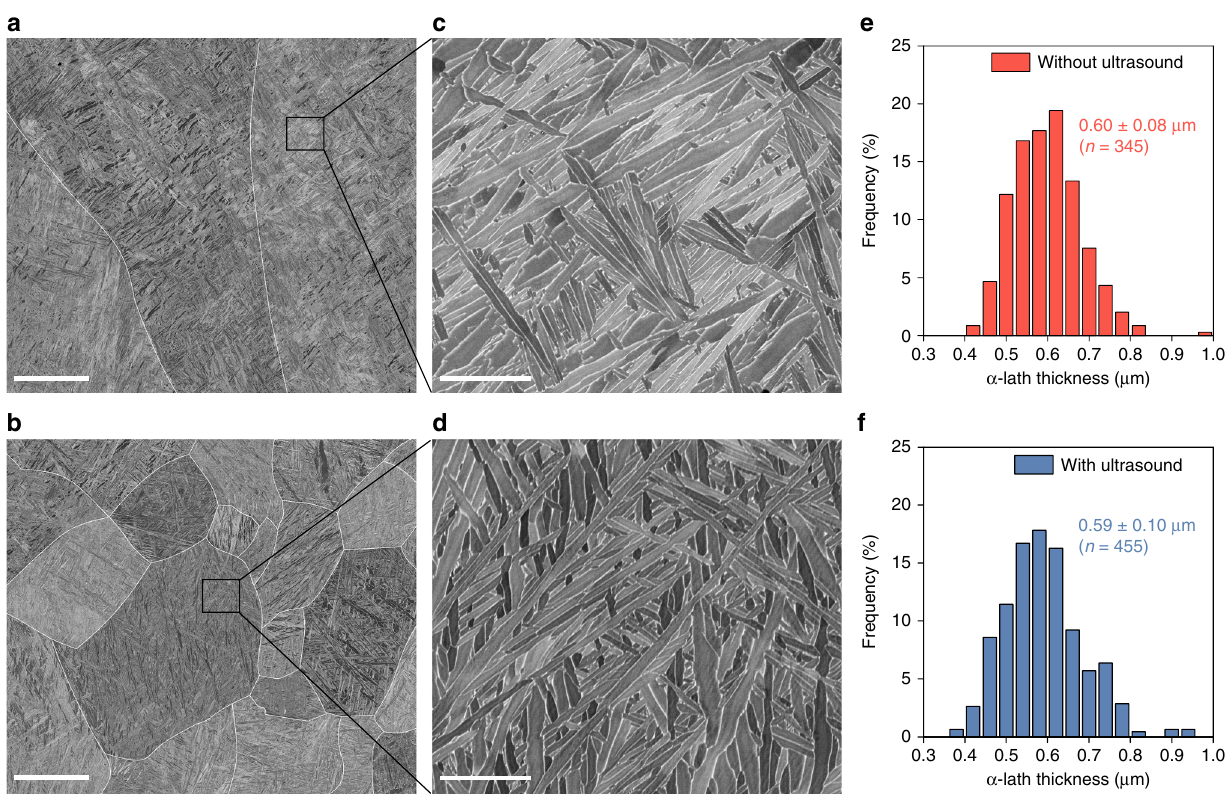
Fig. 3 Microstructure characterization of the AM-fabricated Ti-6Al-4V with and without high-intensity ultrasound. a – d SEM images showing the α – β structure inside the prior- β grains of the samples without ( a , c ) and with ( b , d ) ultrasound. e , f Histograms of the α -lath thickness of the samples without ( e ) and with ( f ) ultrasound. The prior- β grain boundaries in a and b are traced in white. Scale bars, 50 μ m in a , b and 5 μ m in c , d